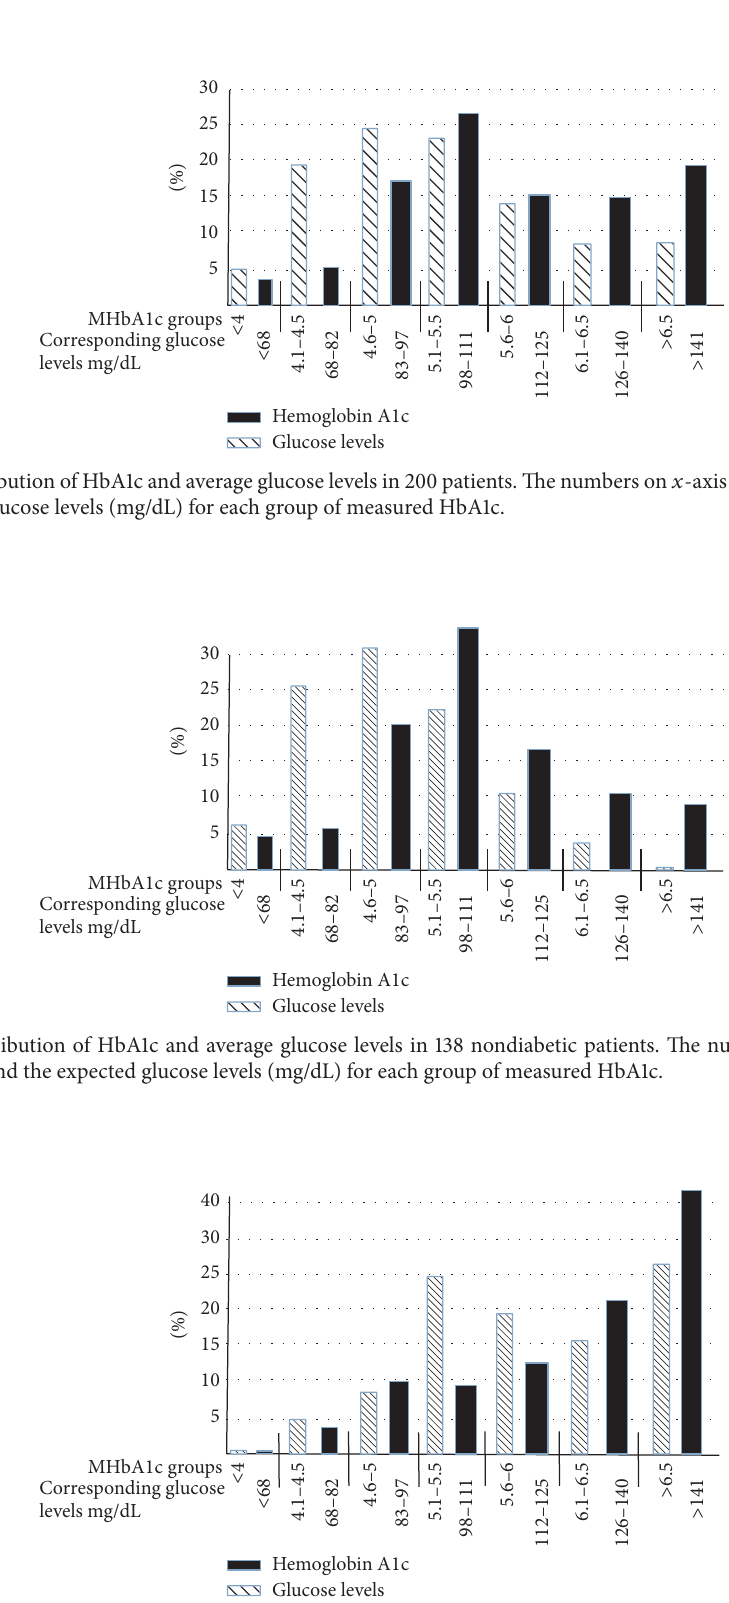
Figure 3: Percentage distribution of HbA1c and average glucose levels in 62 diabetic patients. The numbers on 𝑥 -axis represent the measured HbA1c groups and the expected glucose levels (mg/dL) for each group of measured